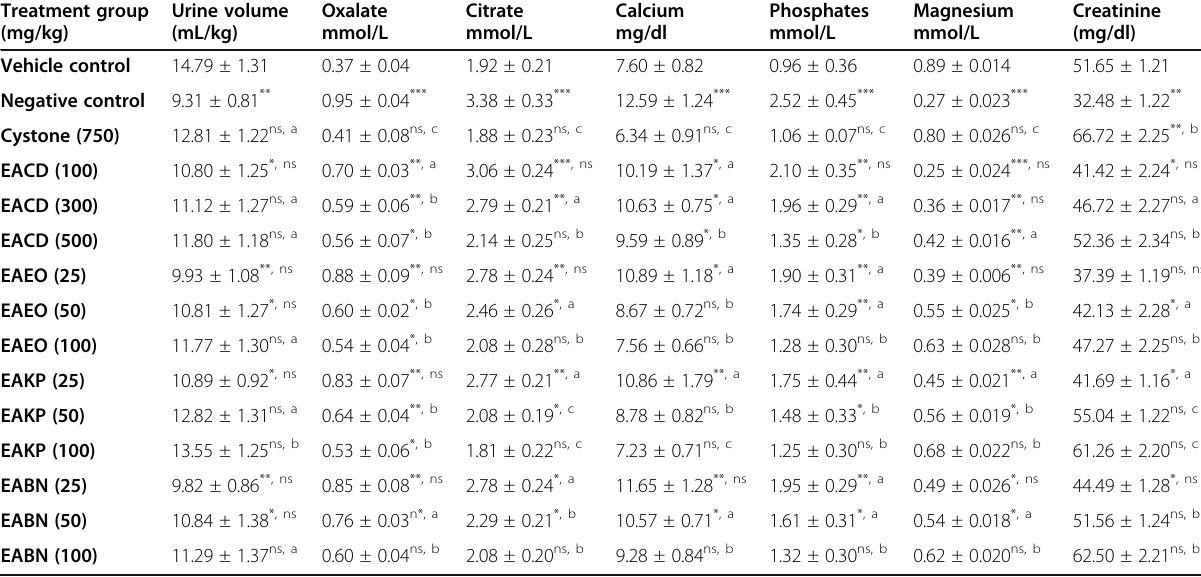
Table 1 Urine biochemical parameter of glyoxalate induced nephrolithiatic mice treated with ethyl acetate fraction of C. dactylon , E. officinalis , K. pinnata , and B. nutans Treatment group